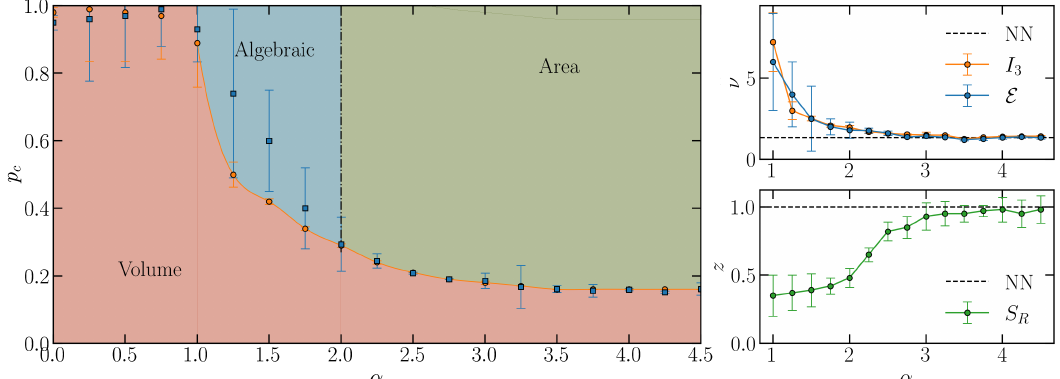
Figure 7: (Left) Phase diagram of the LRHRC. The analysis is performed with the TMI which presents sensibly less finite size effect compared to other quantities. The ( α ) . For comparison we also orange markers identifies the line of phase transitions p c present the estimated phase transition from the logarithmic negativity (blue mark- ers). As clear from the error bars, the FSS suffers larger finite size effects compared to the TMI. Lastly, the crossover line at α = 2 is obtained through the analysis of the negativity (cfr. Fig. 9) and by analytical arguments in the main text. (Right) Cor- relation length critical exponent as extracted from I and E , and dynamical critical 3 exponent obtained through he analysis of S . For comparison, the dashed line NN, R refers to the short-range